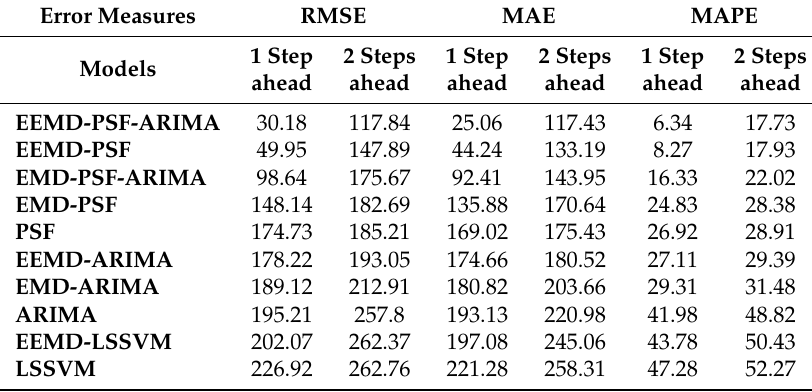
Table 3. Comparison of proposed methods with reported methods on RMSE, MAE and MAPE for one and two step ahead (iterate strategy) forecasting with wind power time-series.